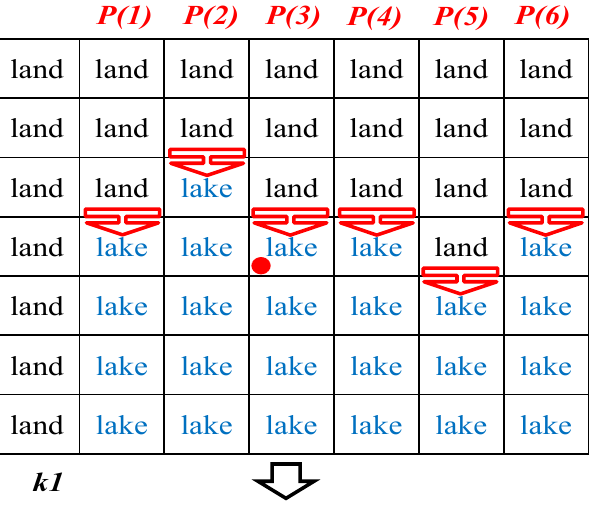
Figure 4. Slope calculation diagram, with land and lake pixels marked as black and blue, respectively. The red point is the slope calculation point, whose location is shown in a plan view in Figure 3. The P ( i ) is the slope from the land to lake as indicated by the red arrow symbol, with the black arrow symbol on the bottom showing the direction of calculation. k 1 is the final average slope value, which is calculated from Equation (2).